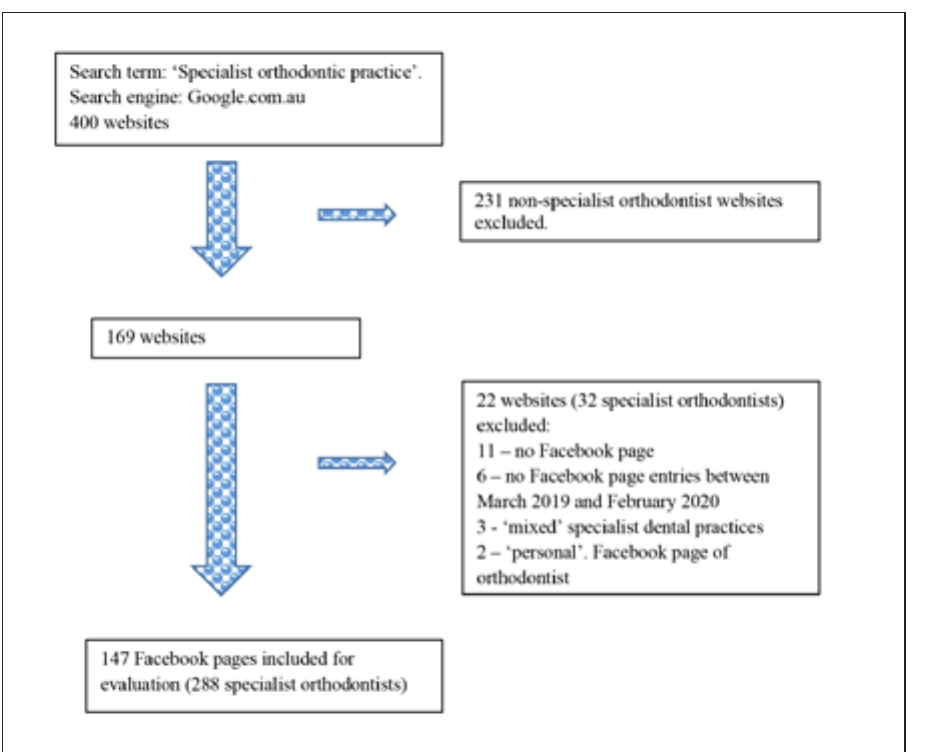
Figure 1. Flowchart showing Facebook pages selection.